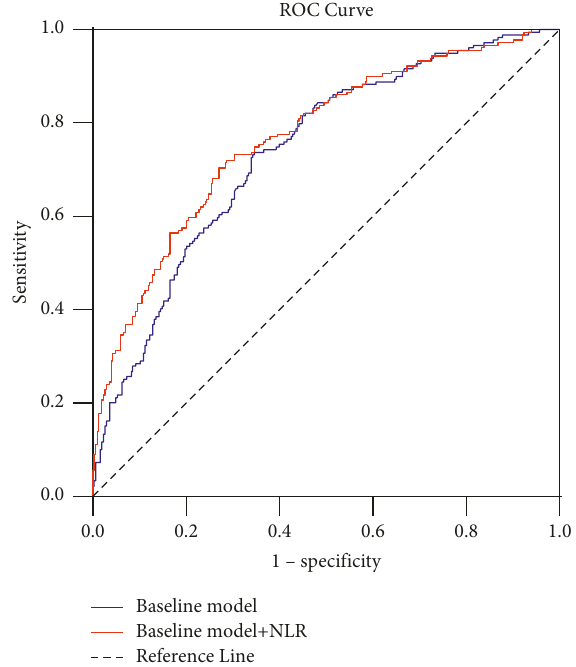
Figure 2: ROC curves for the baseline model and baseline mod- el+ NLR for predicting the requirement of invasive mechanical ventilation in patients with ARDS. ROC, receiver operating characteristics; NLR, neutrophil-to-lymphocyte ratio; baseline model+NLR: the integration parameters of baseline model and NLR; ARDS, acute respiratory distress syndrome.